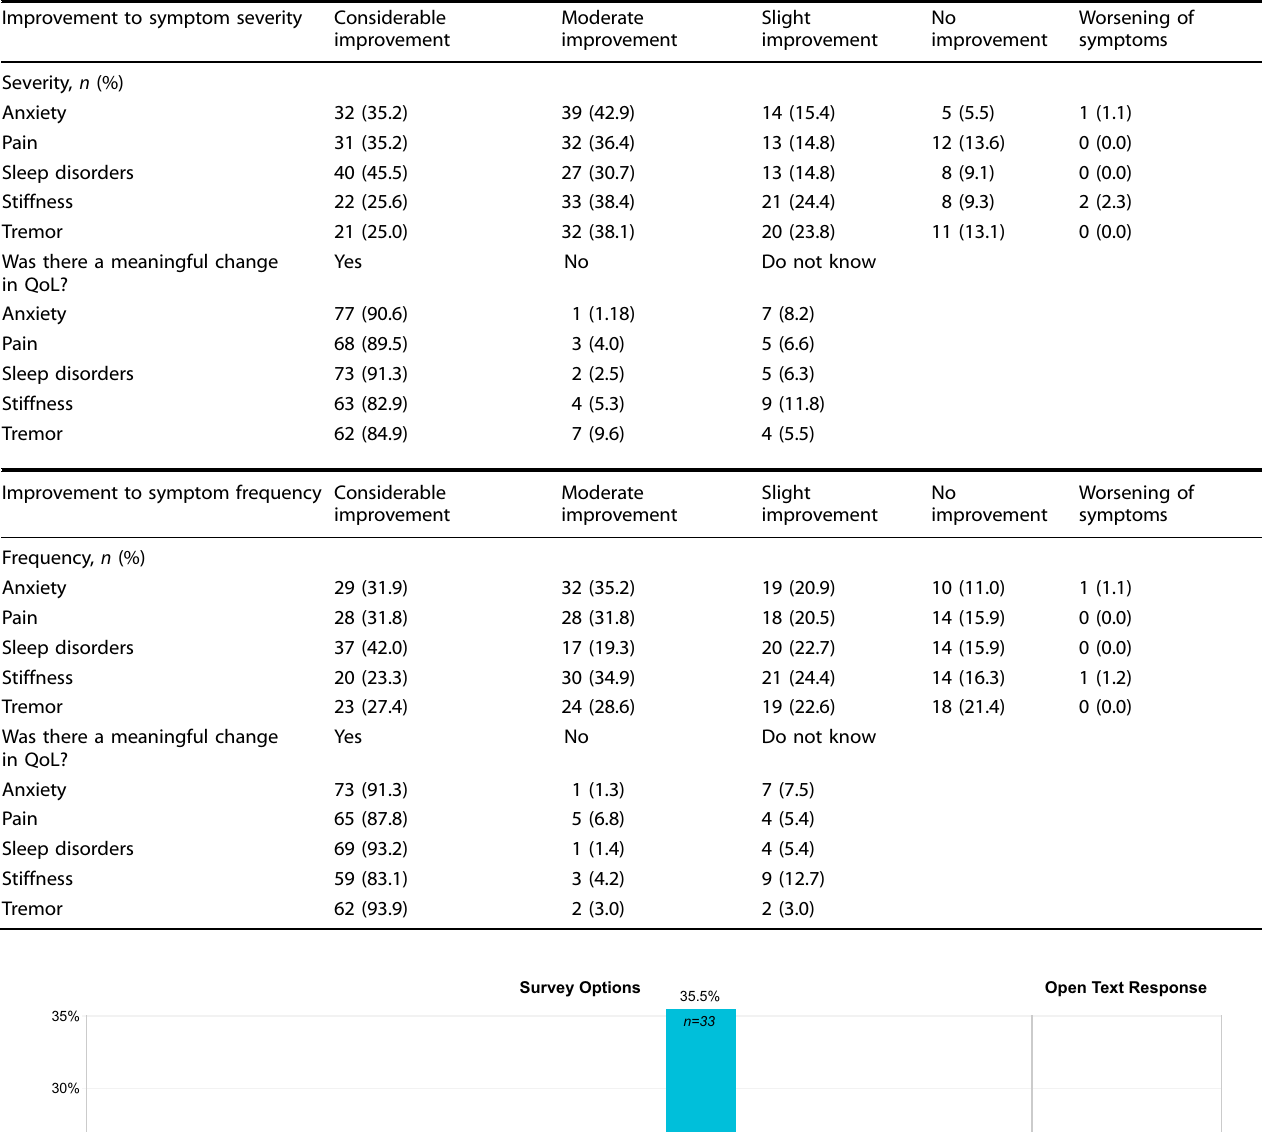
Table 7. Reported Cannabis symptom improvement for top selected symptoms, n (%).